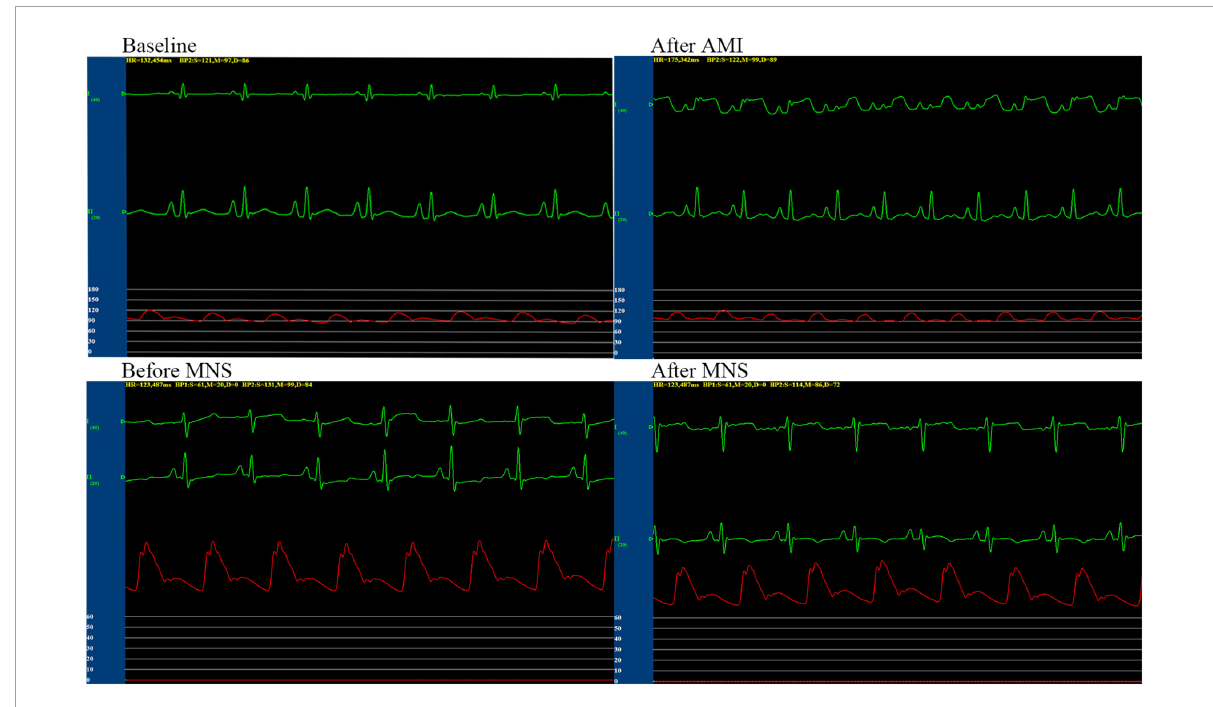
FIGURE4 Representative graphs of blood pressure, heart rate, and electrocardiographic monitoring in the MNS1 group dog during baseline, acute myocardial infarction (MI), and before and after 30 min of MSN. MSN, median nerve stimulation.